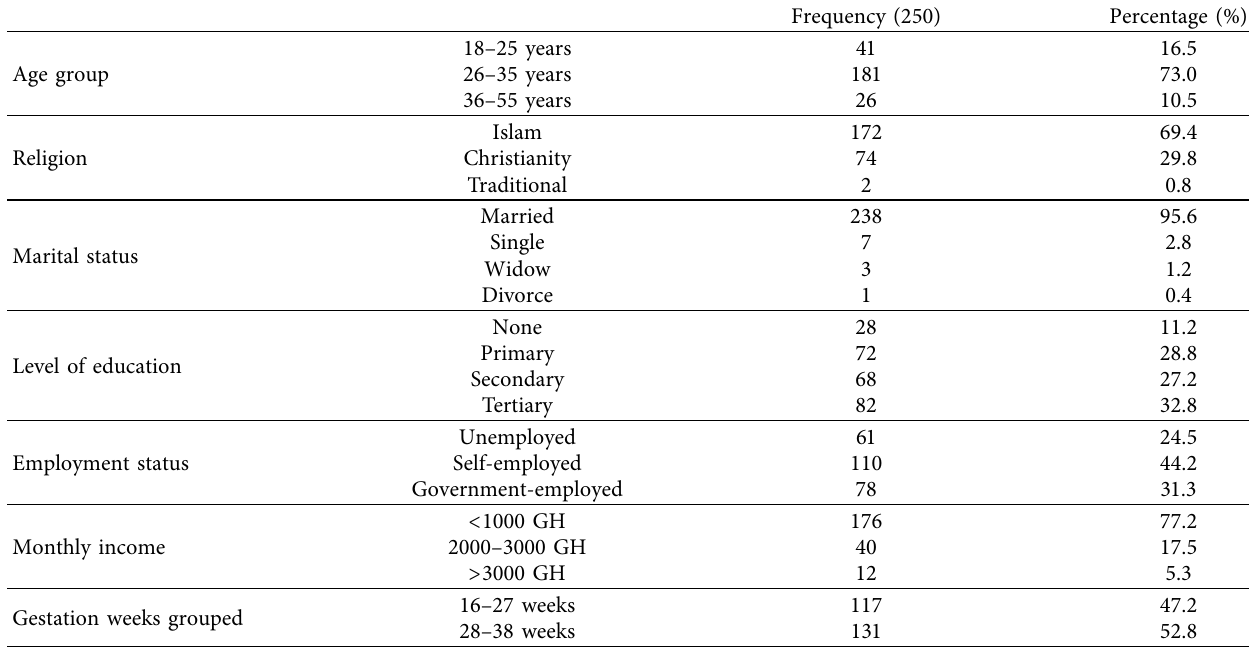
Table 1: Demographic characteristics of the